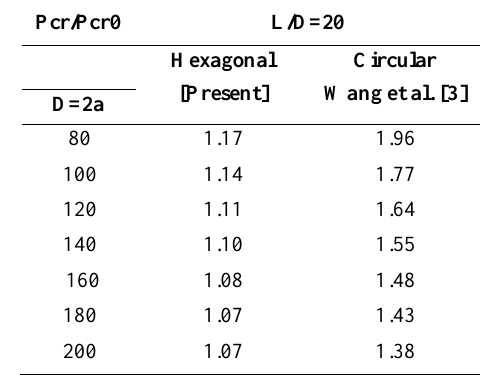
Table 2 . The critical compressive load of axial buckling of cr